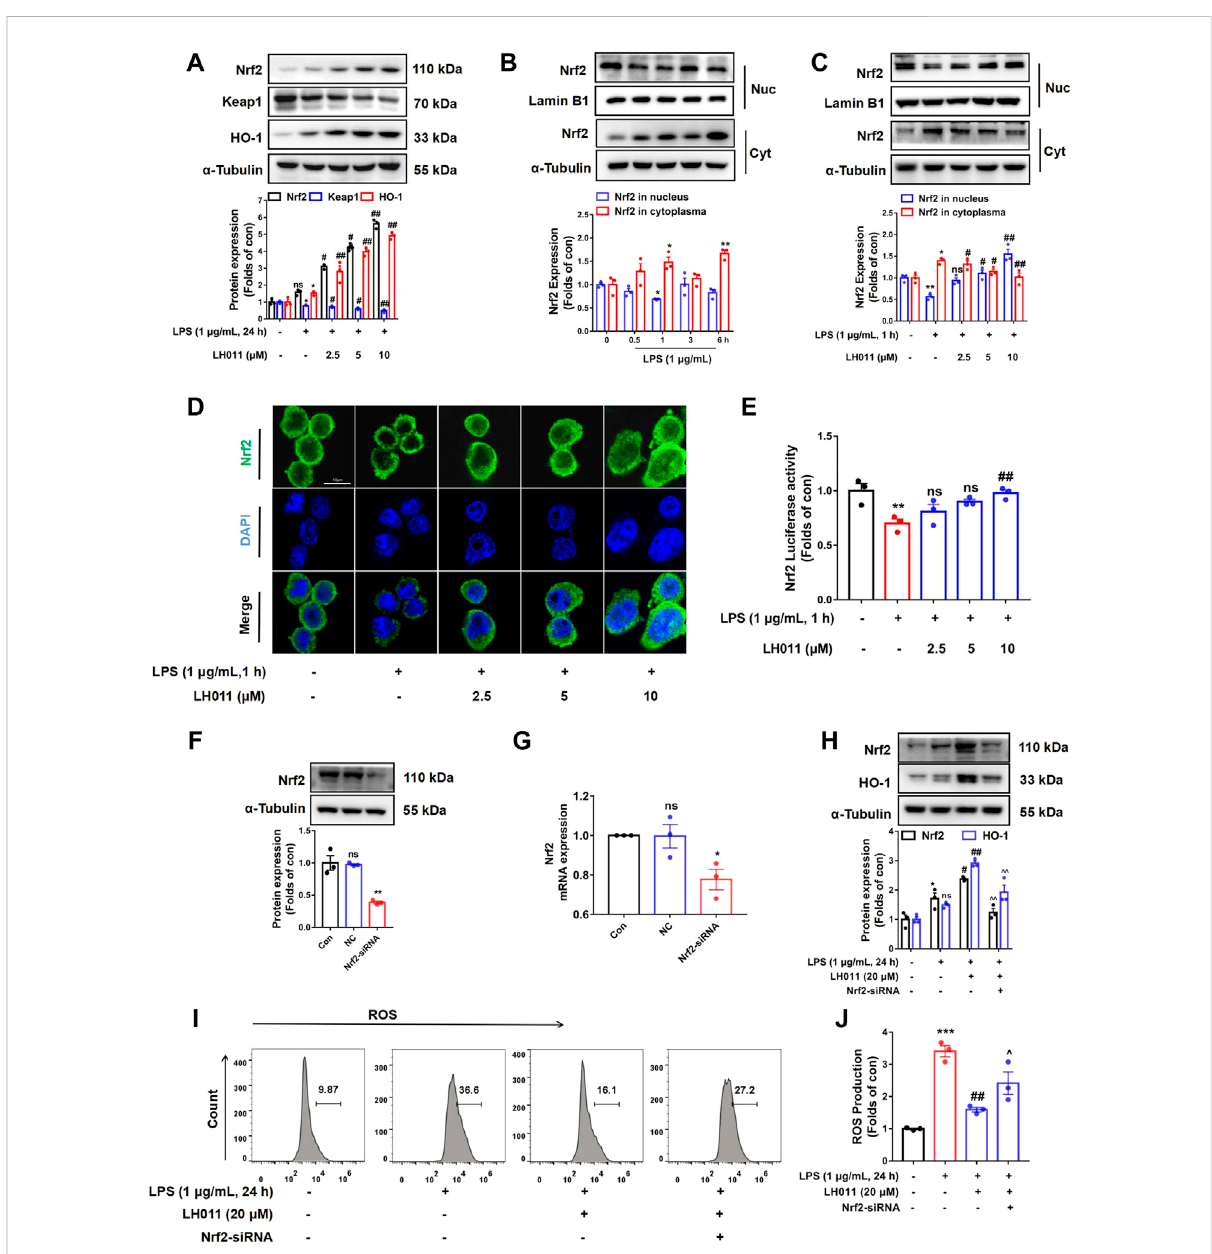
FIGURE 7 LH011 increased Nrf2/Keap1/HO-1 activation in RAW 264.7 cells. (A) Protein levels of Nrf2, Keap1, and HO-1 were measured by Western blot in RAW264.7 cells. (B) Nucleic proteinwasextracted and thelevel ofNrf2 wasmeasured withLPSstimulateatdifferenttime points. (C) Nucleicprotein was extracted and the level of Nrf2 was measured with LPS and LH011 co-stimulate. (D) Sub-localization of Nrf2 was measured by immuno fl uorescence,scalebar:10 μ m. (E) TranscriptionalactivityofNrf2wasmeasuredbydual-luciferasereporterassaywithLPSstimulateat 1 h. (F,G) Nrf2 wassilenced bytargetingsiRNA.The proteinand themRNA levels ofNrf2 weremeasured. (H) Protein changes ofNrf2 andHO-1were measured by Western blot. (I,J) Change of ROS was detected by fl ow cytometry. All data are presented as the mean ± SEM (n = 3). * p < 0.05, ** p